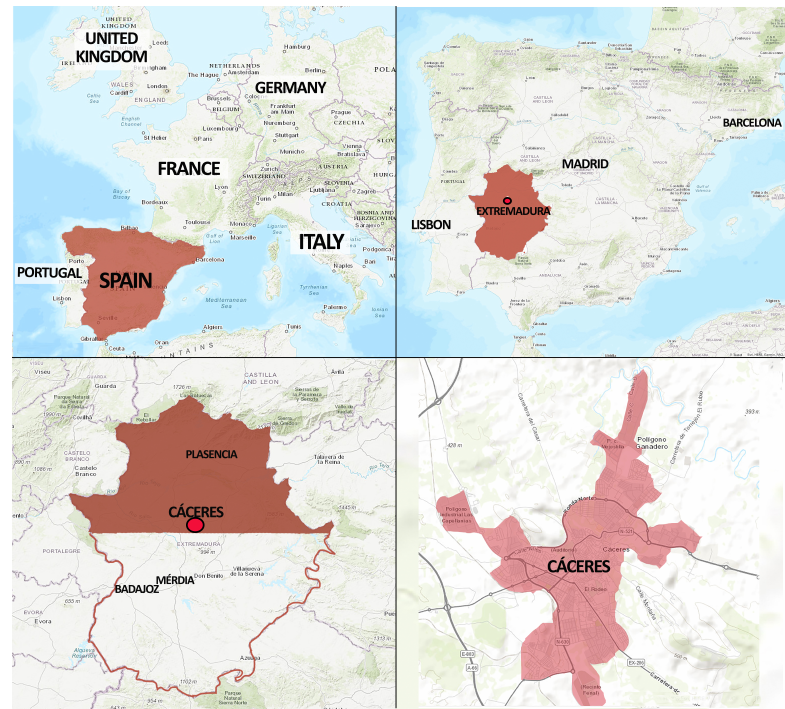
Figure 1. Location of Cáceres within Europe, Spain and the autonomous community of